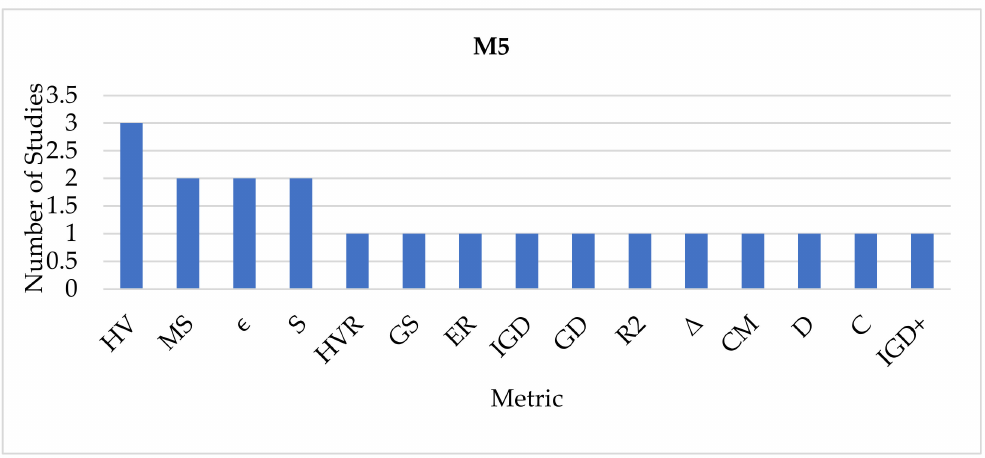
Figure 8. Metrics distribution in M5